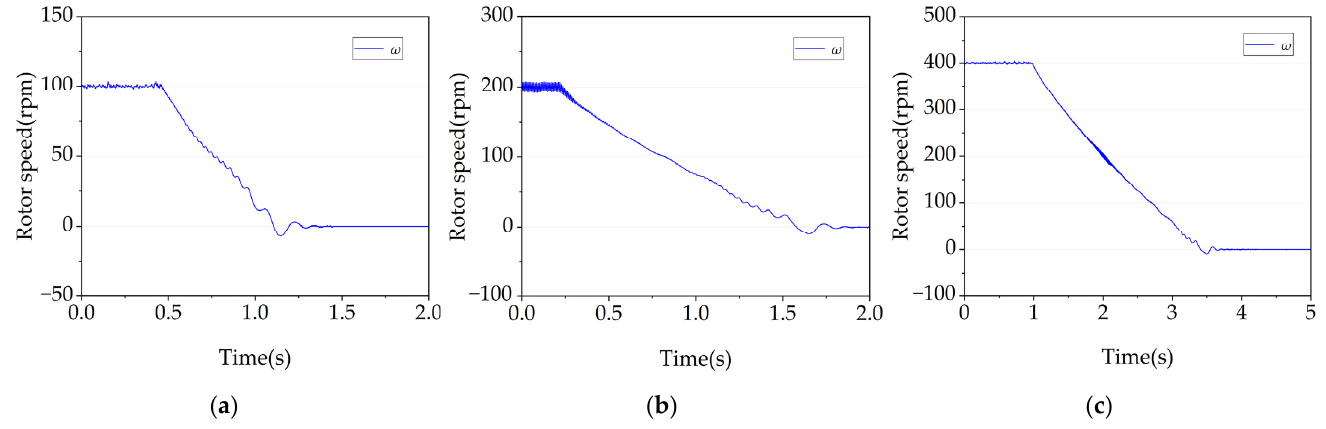
Figure 11. PMSM waveforms at free-running condition with different initial speeds. ( a ) 100 rpm. ( b ) 200 rpm. ( c ) 400 rpm.